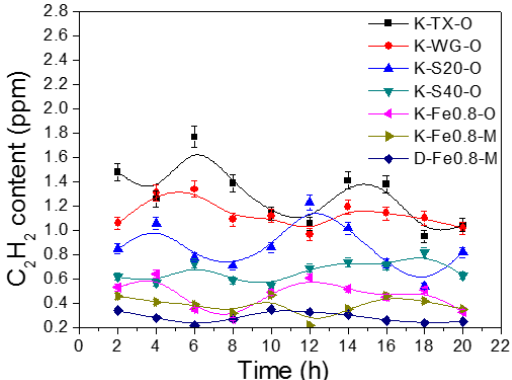
Figure 6. Catalytic abatement of acetylene through hydrochlorination over prepared samples (K-TX-O, K-WG-O, K-S20-O, K-S40-O, K-Fe0.8-O, K-Fe0.8-M, D-Fe0.8-M) at T = 120 ◦ C, total pressure of 0.3 Mpa, GHSV = 4 mL min − 1 g − 1 , t = 20 h, and 2000 ppm C 2 H 2 balanced by HCl (>99.5%), error bar of